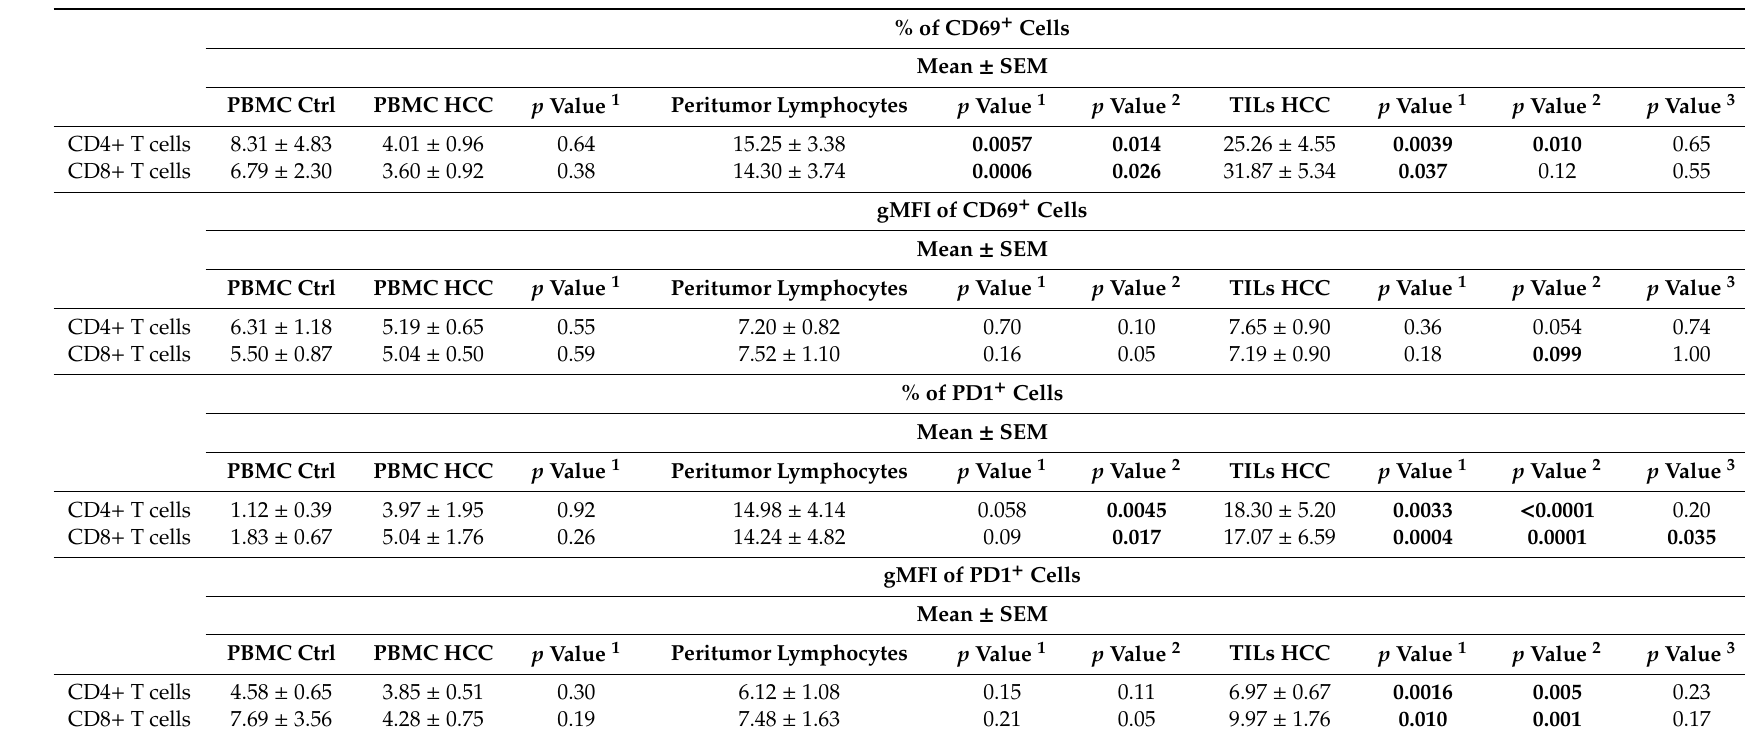
Table 5. PD-1 and CD69 expression on T cell